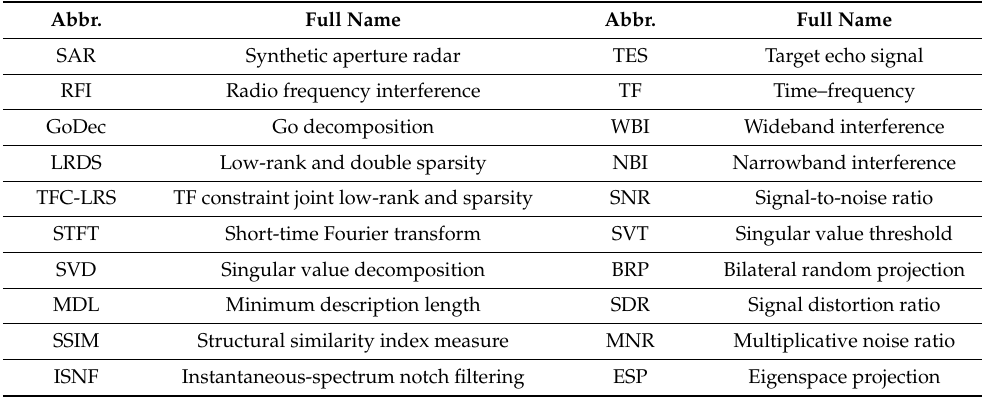
Table 1. Comparison table of abbreviations.